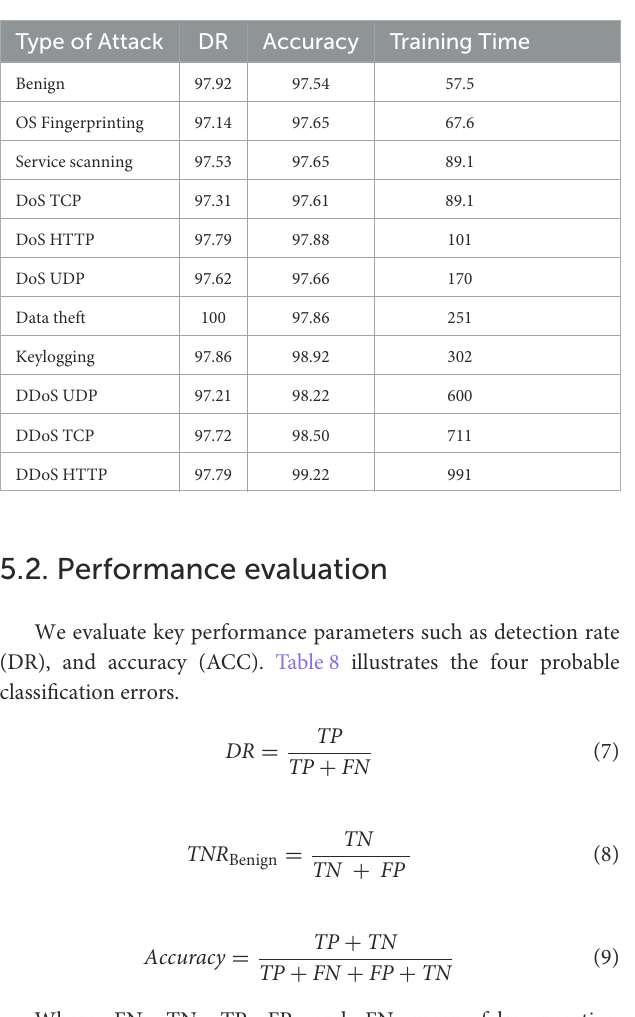
TABLE 9 Performance of the DNN model relative to the different attack types and benign in terms of DR, accuracy, and training time on the BoT-IoT dataset.